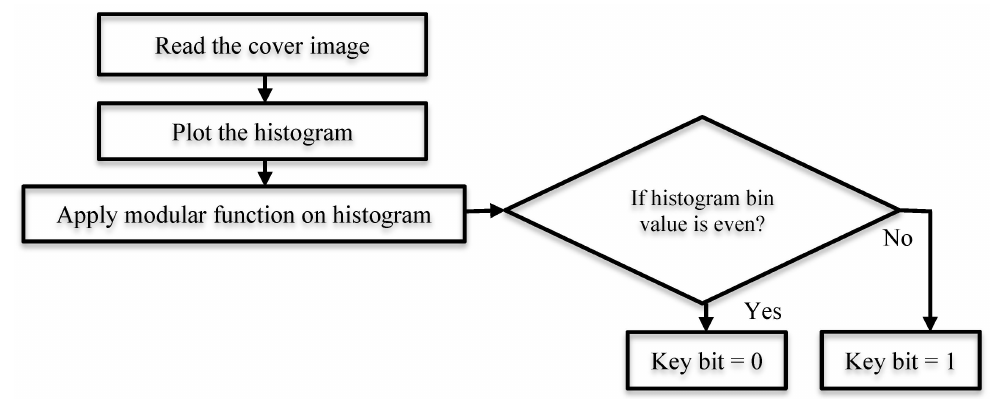
Figure 6. Flow diagram of key